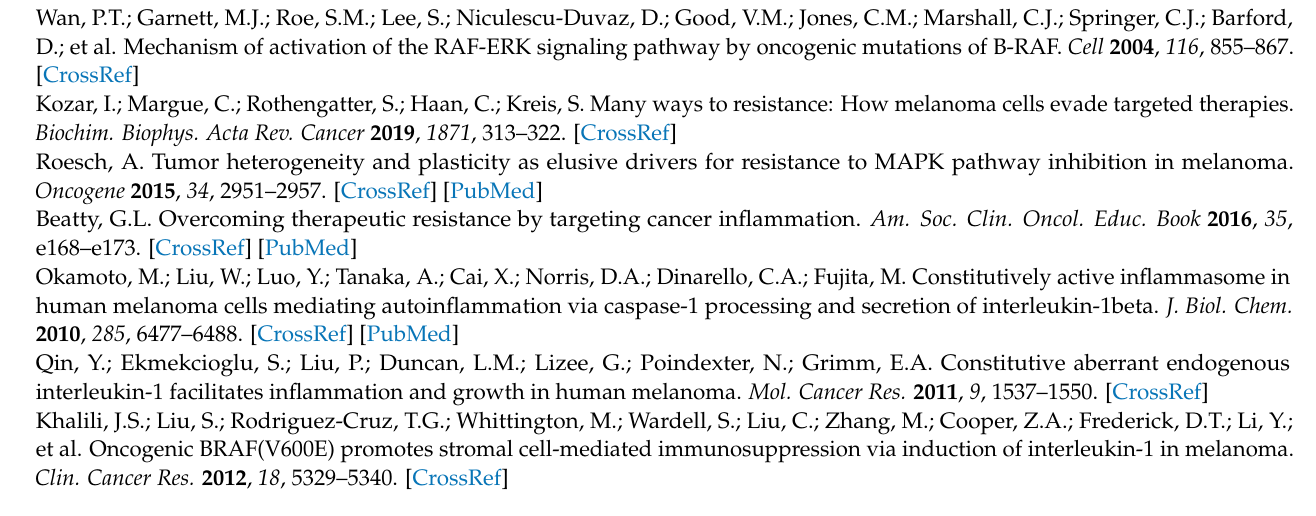
Figure S2: Original blots of Figures 1c, 2b and 4e. Figure S3: Putative ATF4 binding site within the NLRP1 promoter. Figure S4: Original blots of Figure 1d. Figure S5: Original blots of Figure 2e. Figure S6: Synergistic inhibition of NLRP1 protein expression by RSKi and VEM in A375 and 1205Lu cells. Figure S7: Original blots of Figure 3b. Figure S8: Original blots of Figures 3c and 4c,f. Figure S9: Original blots of Figure 3e. Figure S10: MITF and AXL gene expression in MAPK inhibitor-resistant SK-MEL-28 cells. Figure S11. IL1B gene expression is inversely related to the expression ratio of MITF / AXL in melanoma cells as shown in Figure S1. Figure S12: Original blots of Figure 4d. Figure S13: Decreased IL1B mRNA expression and IL-1 β production in 1205Lu cells treated with 1 µ M vemurafenib (VEM) or 0.5 µ M trametinib (TRA). Figure S14: Pretreatment of 1205Lu